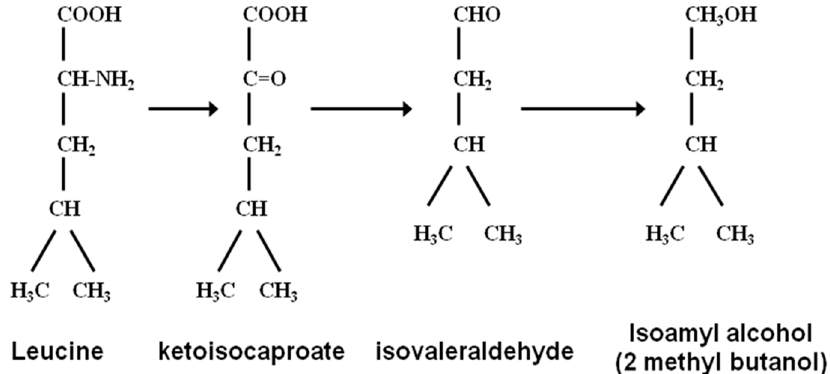
Figure 6. Ehrlich pathway–relationship between higher (fusel) alcohols and amino acids.